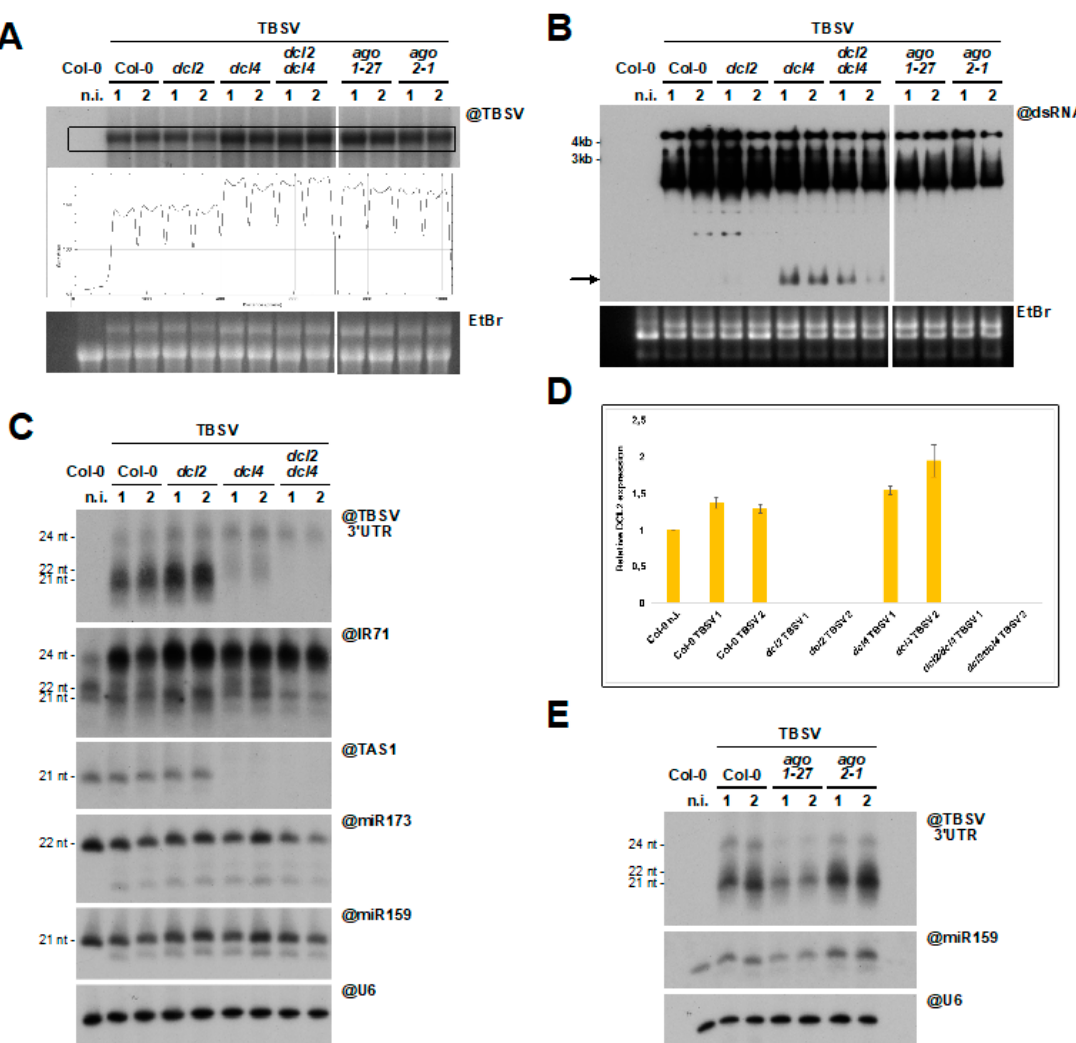
Figure 7. Atypical RNA silencing response to TBSV infection in A. thaliana . ( A ) Northern blot of high molecular weight RNA to detect TBSV in systemically infected rosette leaves, 10 dpi, of A. thaliana mutant lines. Quantification of signal intensity is provided. Each sample is a pool of 4–5 plants. ( B ) Northwestern blot to detect dsRNA in the samples described in ( A ). The black arrow indicates the dsRNA band observed upon genetic knock-out of DCL4 . In ( A , B ) EtBr gel staining was used as a loading control. ( C ) Northern blot analysis of low molecular weight RNA to detect TBSV-derived and endogenous small RNA. The same membrane was repeatedly stripped and re-probed. ( D ) RT-qPCR of the samples analyzed in ( A – C ) to assess accumulation of DCL2 mRNA. Expression levels were normalized to UBIQUITIN 10 (UBQ10) and ACTINE2 mRNA. Primers were designed on the opposite sides of the dcl2-1 T-DNA insertion to rule out non-specific amplification. ( E ) Northern blot analysis of low molecular weight RNA to detect TBSV-derived siRNA in the ago mutants analyzed in ( A , B ). As in ( C ), miR159 and snU6 were used as loading controls.